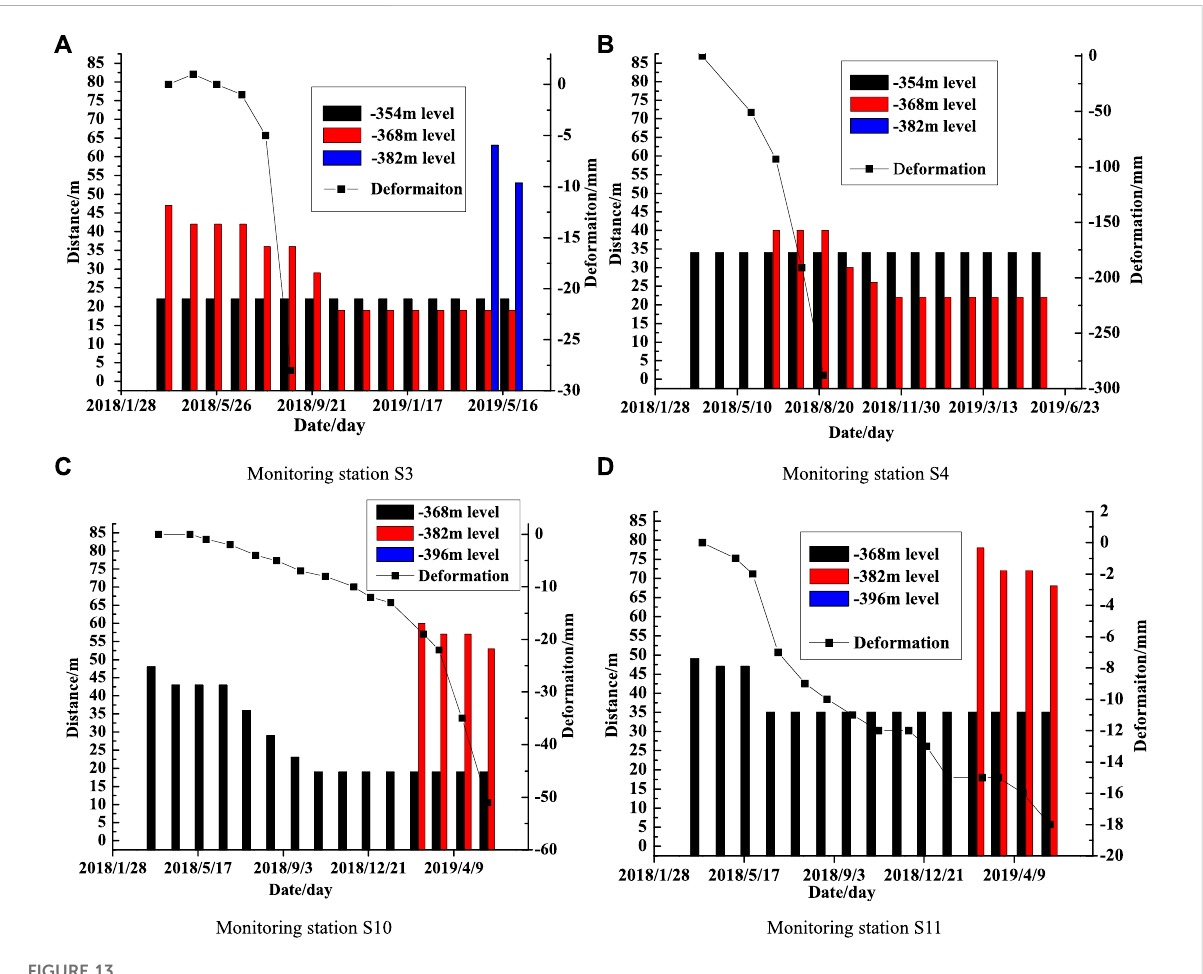
FIGURE 13 Relationship between deformation of monitoring stations (S3, S4, S10, and S11) and mining under rectangular coordination system. (A) Monitoring station S3. (B) Monitoring station S4. (C) Monitoring station S10. (D) Monitoring station